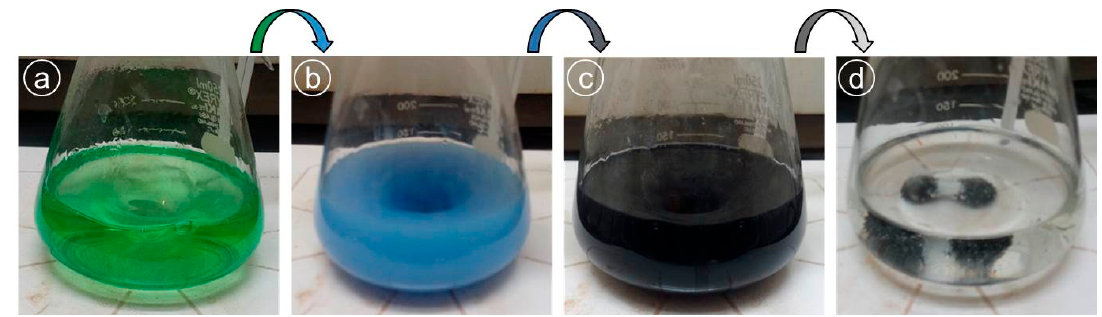
Figure 1. Different stages during the synthesis of NiNPs ( a ) color of nickel precursor solution, ( b ) hydrazine turned the color of solution to blue-violet, ( c ) solution color tuned to black afterwards, and ( d ) finally NiNPs recovered magnetically.